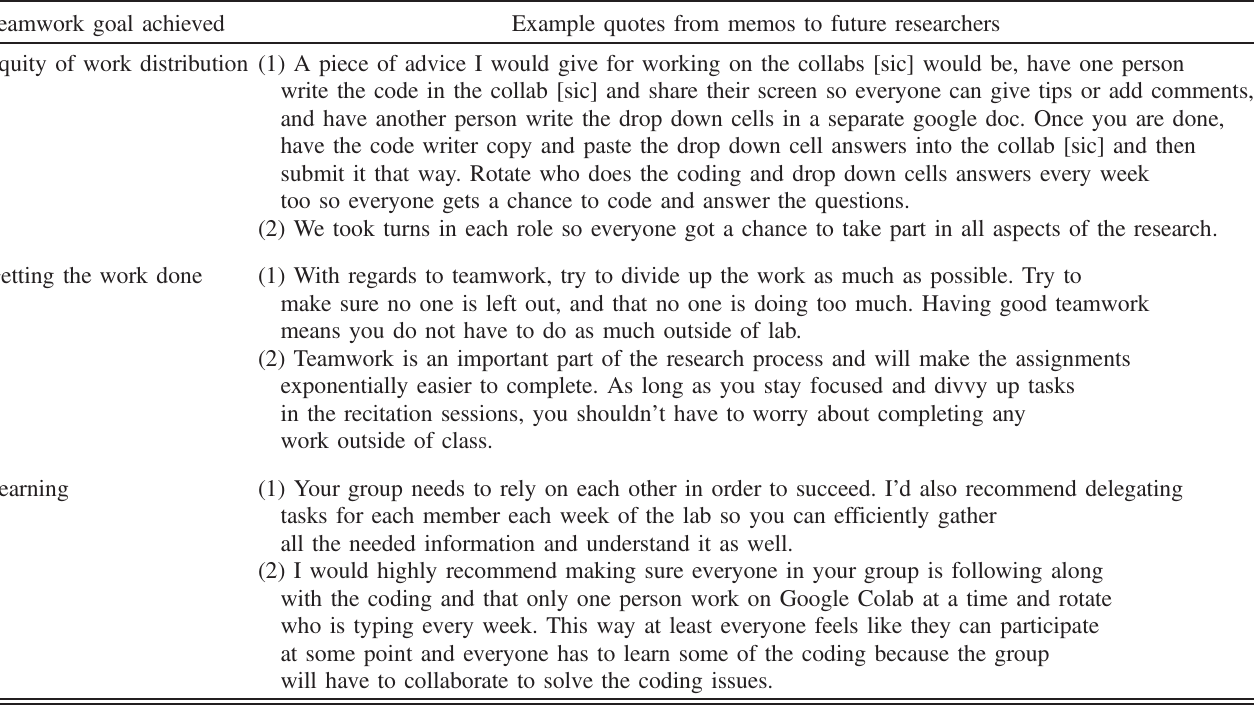
TABLE VII. Example quotes highlighting various teamwork goals that students expressed they could achieve through dividing the work.